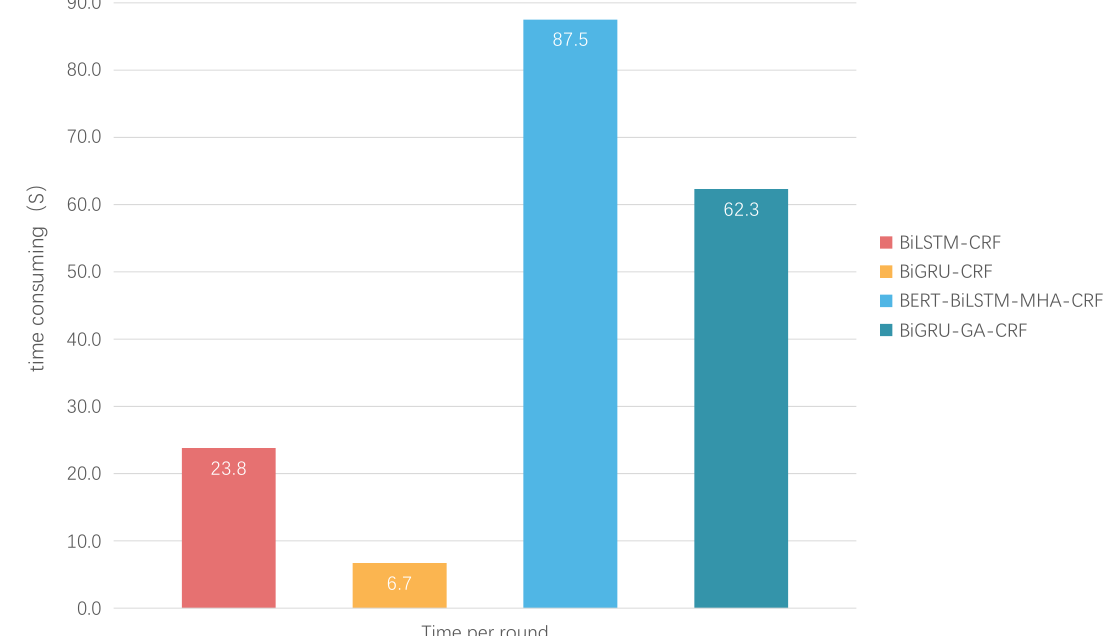
Figure 13. Each round of the entity extraction model takes time to compare the experimental re- sults.